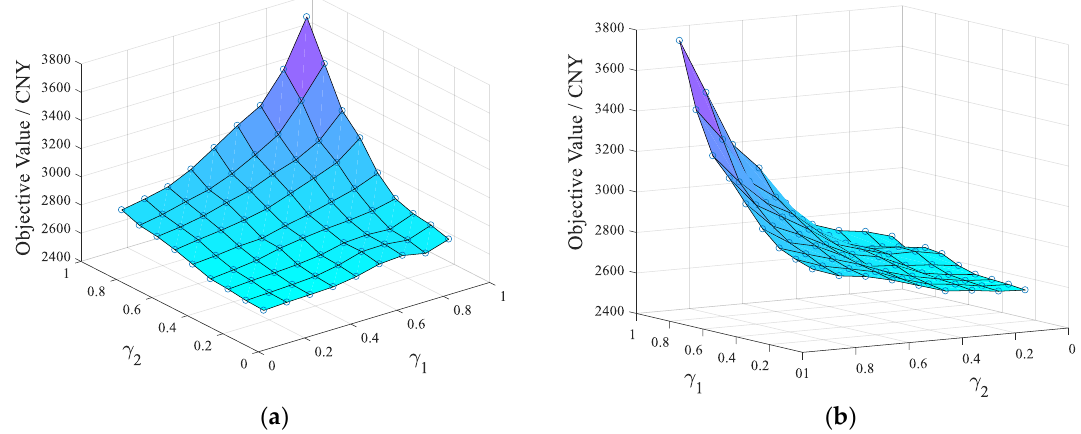
Figure 5. Relationship between objective value and postharvest quality deterioration factor. ( a ) Objective value under different values of γ 1 and γ 2 ; ( b ) The variation trend between objective value and γ p .